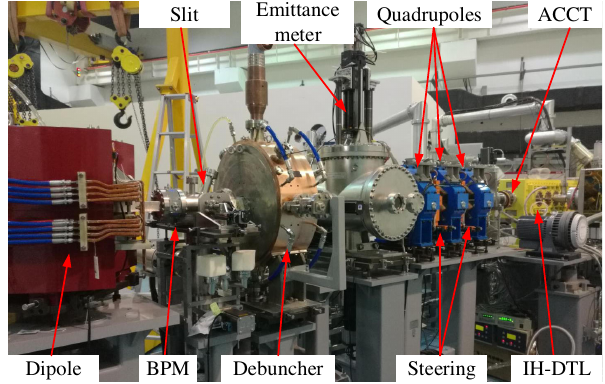
FIG. 12. Test beamline of the